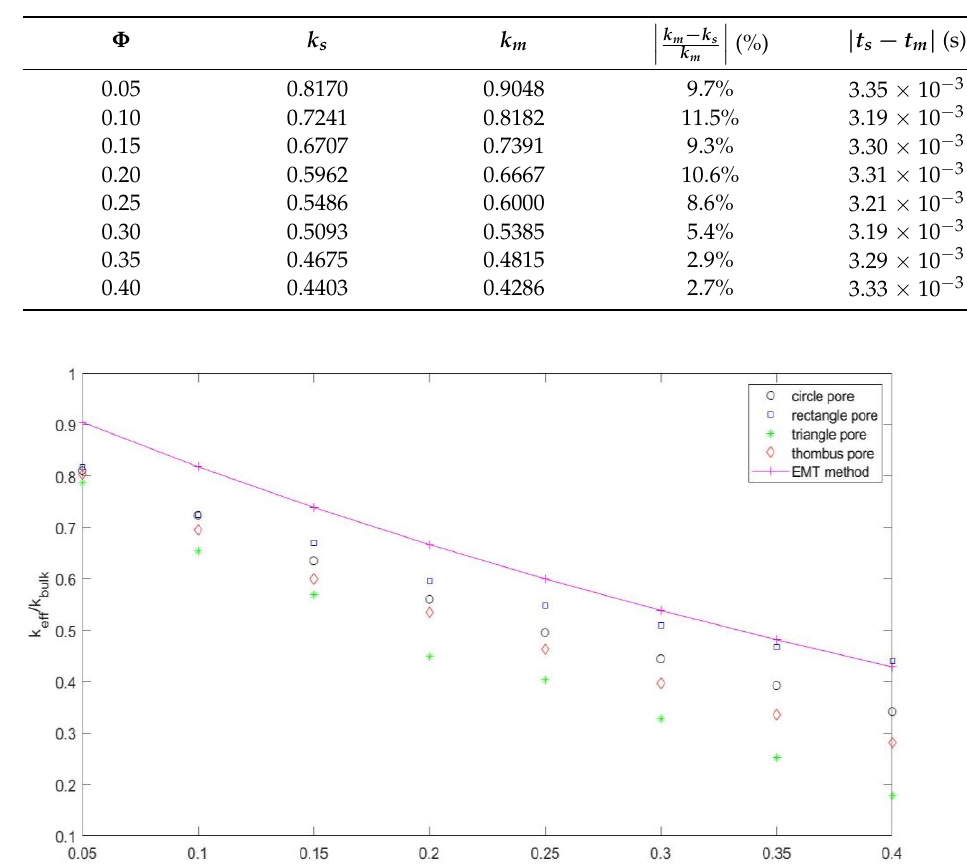
Figure 3. The effective thermal conductivity with two methods in AlN, at 300k.